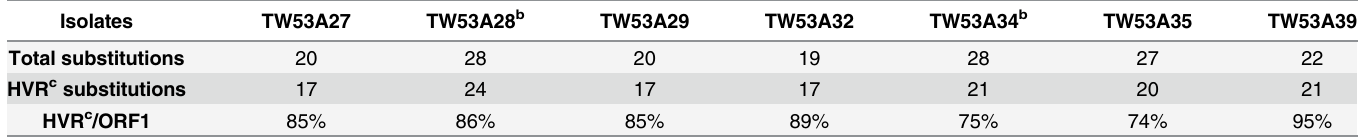
Table 3. Count of amino acid substitutions a for putative ORF1 protein within TW53A25 sub-clade.